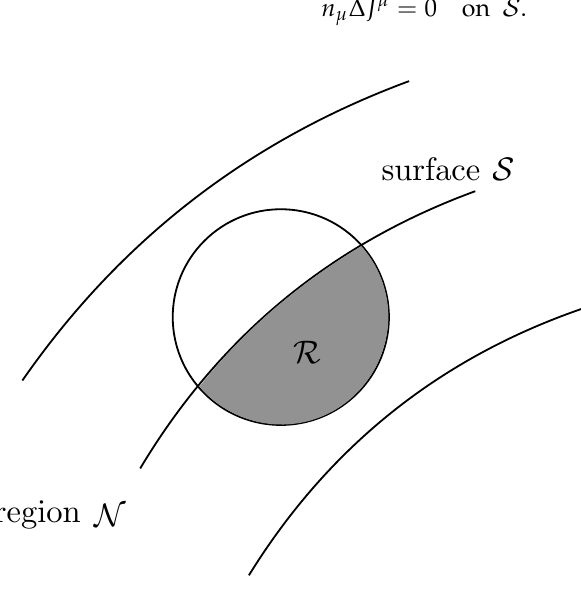
Figure 1. Diagram for the jump